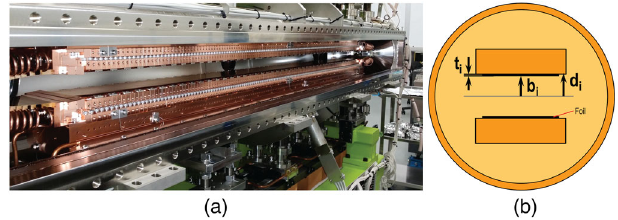
FIG. 3. (a) Image of IVU without the side cover. (b) Schematic cross section of IVU in the middle of the device. The full gap 2 b i between the magnets can be varied from 6 to 40 mm for ID10 and from 5.7 to 40 mm for ID16.